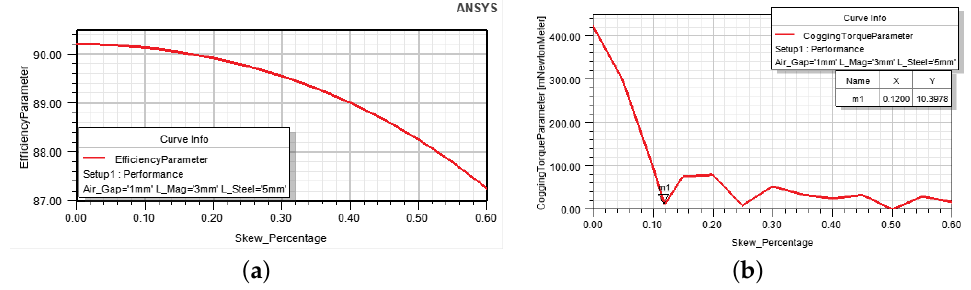
Figure 2. The influence of magnet skewing on ( a ) the efficiency and ( b ) the cogging torque.